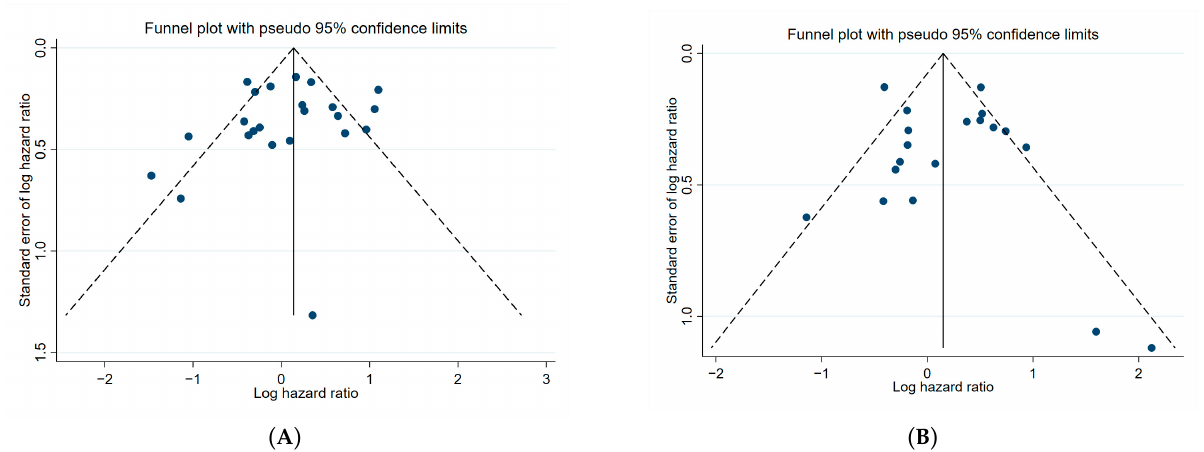
Figure 6. Funnel plot for ( A ) unadjusted overall survival and ( B ) unadjusted progression free survival meta-analysis. The effect estimate (log hazard ratio) was plotted against the standard error of the effect estimate. Individual studies are represented by each point plotted on the graph. The black line centrally located on the graph represents the summary estimate of the effect of positive/high GR expression. The diagonal dotted lines represent the pseudo 95% confidence limits.